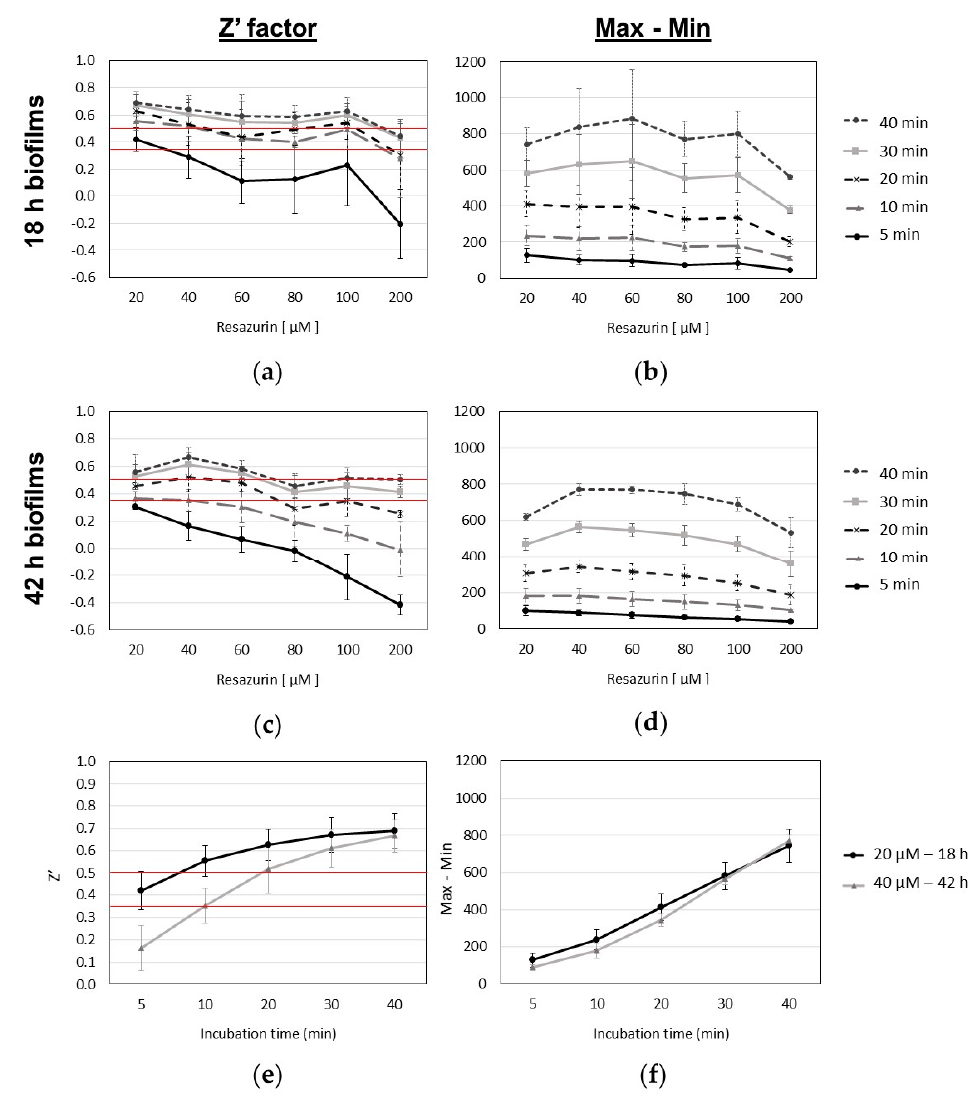
Figure 3. Effect of different resazurin concentrations and incubation times with the dye on the performance of a miniaturized biofilm screening assay in 384WP with S. aureus . Assay performance is measured using Z’ factor ( a , c ) and maximum minus minimum signal ( b , d ) of the resazurin staining of S. aureus biofilms grown for 18 h or 42 h in a volume of 40 µL with a concentration of the bacterial inoculum of 7.00 × 10 4 (CFU) mL − 1 . ( e , f ) show the Z’ factor and the maximum minus minimum signal obtained with the best resazurin concentration over time. Maximum minus minimum results are expressed in RFUs. Results are based on 2–4 independent biological replica experiments performed at room temperature (RT), each plate containing from 12 to 42 technical replicates and 16 media control replicates for each condition. The red lines in panels a, c and e represent the thresholds for determination of the quality of the assay: acceptable (Z’ = 0.35) and good (Z’ = 0.5).